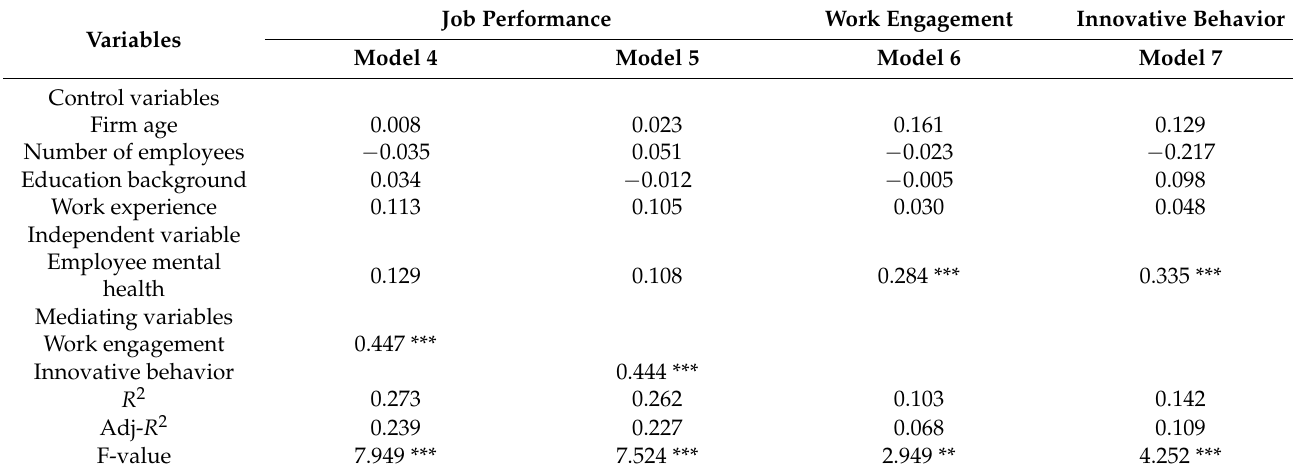
Table 3. The results of regression analysis (models